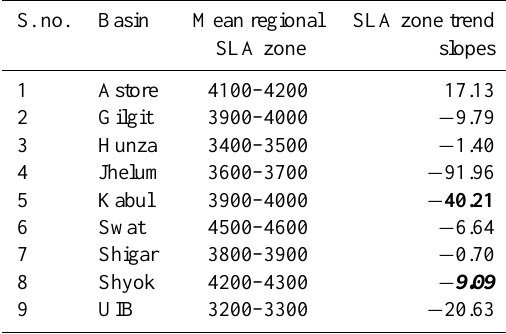
Table 7. Estimated end-of-summer mean regional SLA zone for each studied basin. Note: statistically significant trends at the 95% level are shown in bold and italic, while trends significant at 90% are shown in bold only. Negative values indicate a drop in the SLA zone, while positive values indicate its rise.